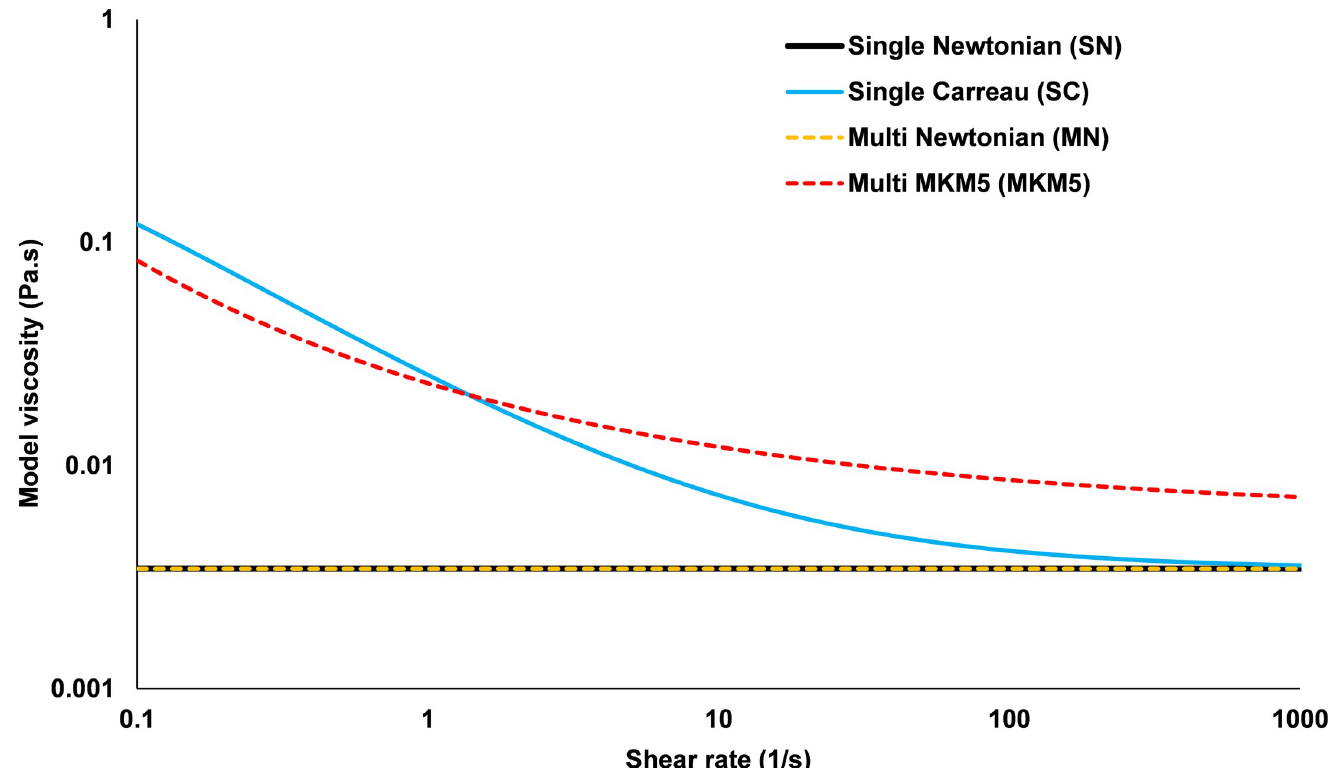
Fig 3. Apparent blood viscosity versus shear rate for the four rheological models (Multiphase models use a Hematocrit of 0.45).